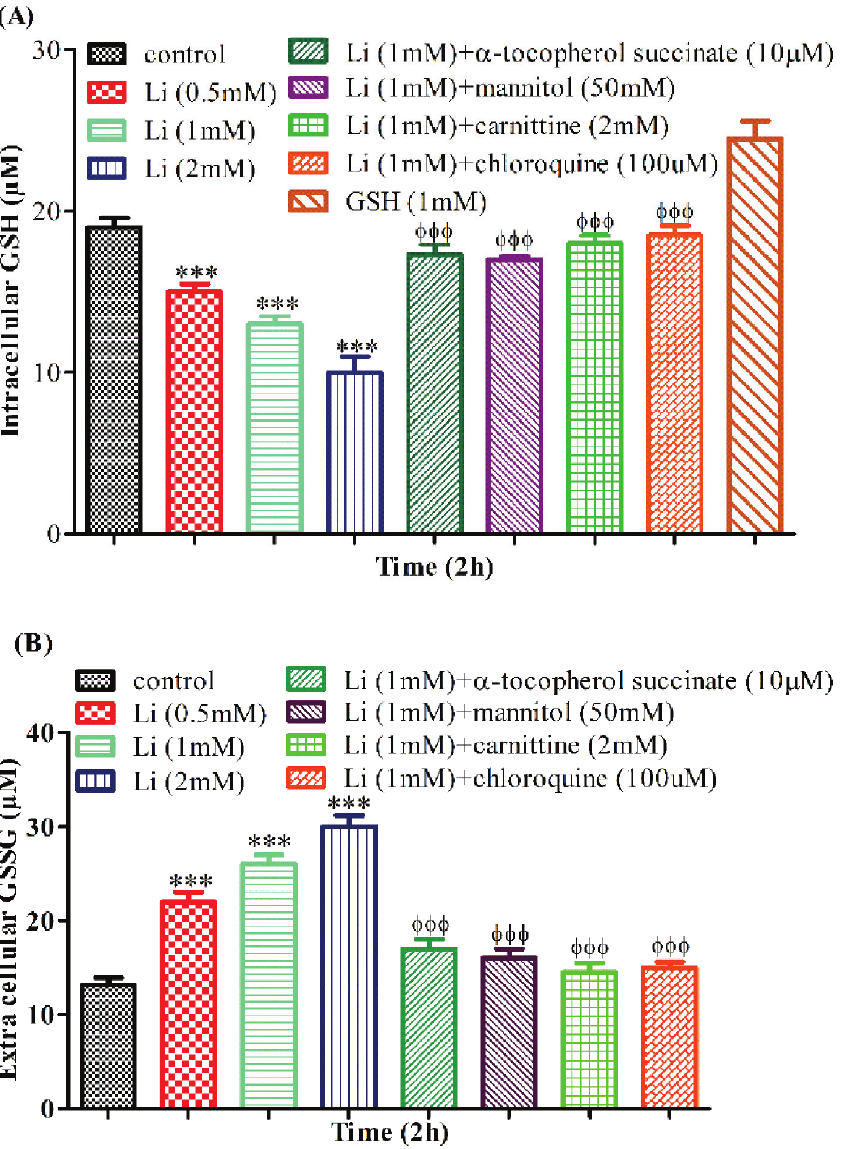
Figure 6: Effect of different concentrations of Li onGSH depletion and the net values of GSH (a) and GSSG (b) using primary neuronal cortical culture. Intracellular GSH and extra cellular GSSG were measured spectrofluorometrically. Values are shown as mean ± SD of three separate experiments (n = 3). *** p < 0.001, significant difference in comparison with non-treated neurons (control). ɸɸɸ p < 0.001, significant difference in comparison with Li (1 mM)-treated